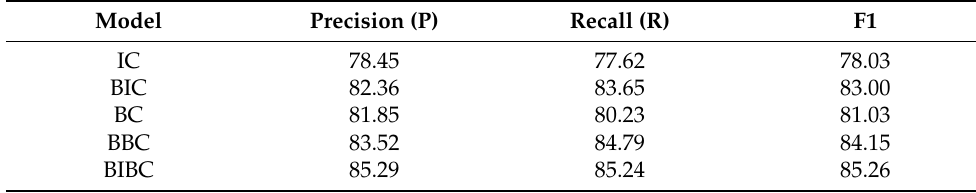
Table 3. Comparison of BIBC model and different baseline model results (Unit: %).